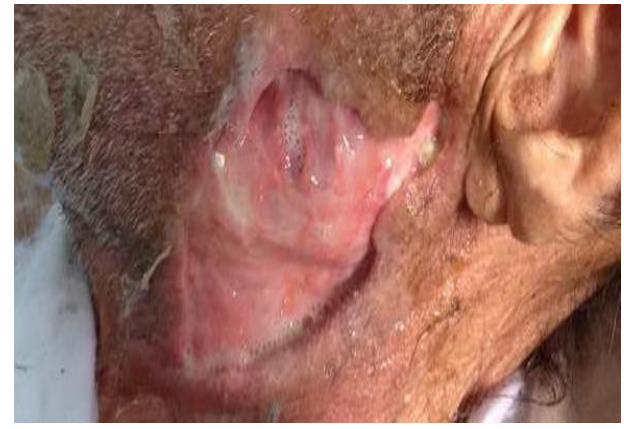
Fig. 4. Evolution of the patient at seven